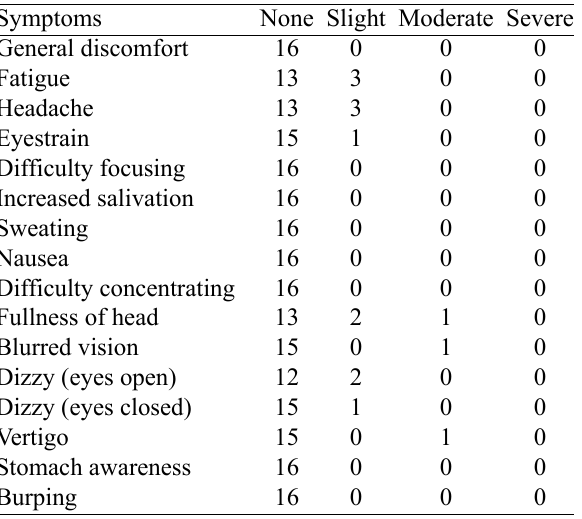
Table 1. Results of the SSQ questionnaire. Total of participants who reported symptoms after the experiment using the “Handlebar mode.”